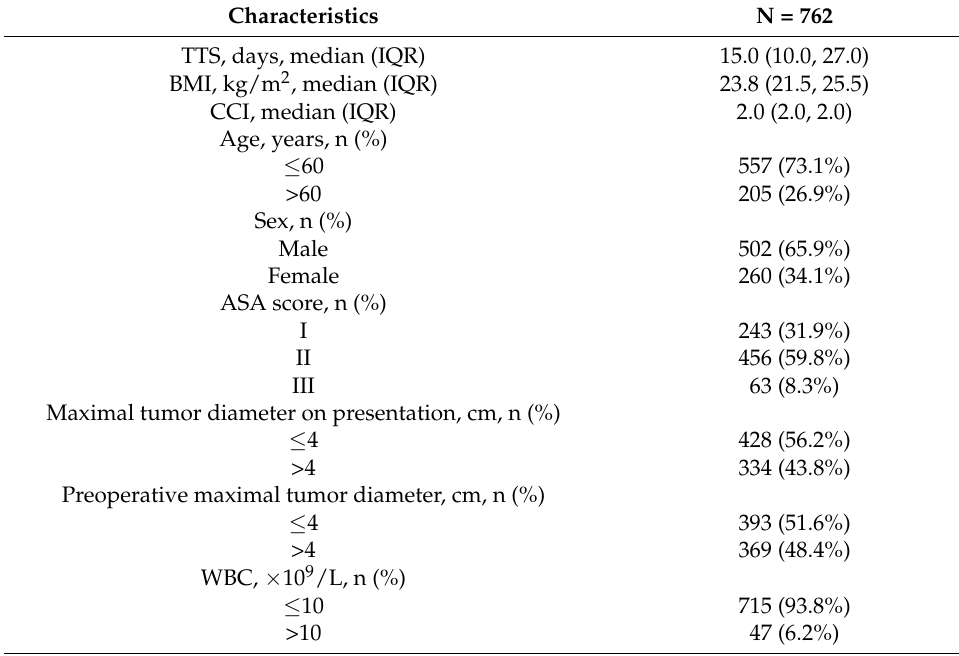
Table 1. Clinical characteristics of all